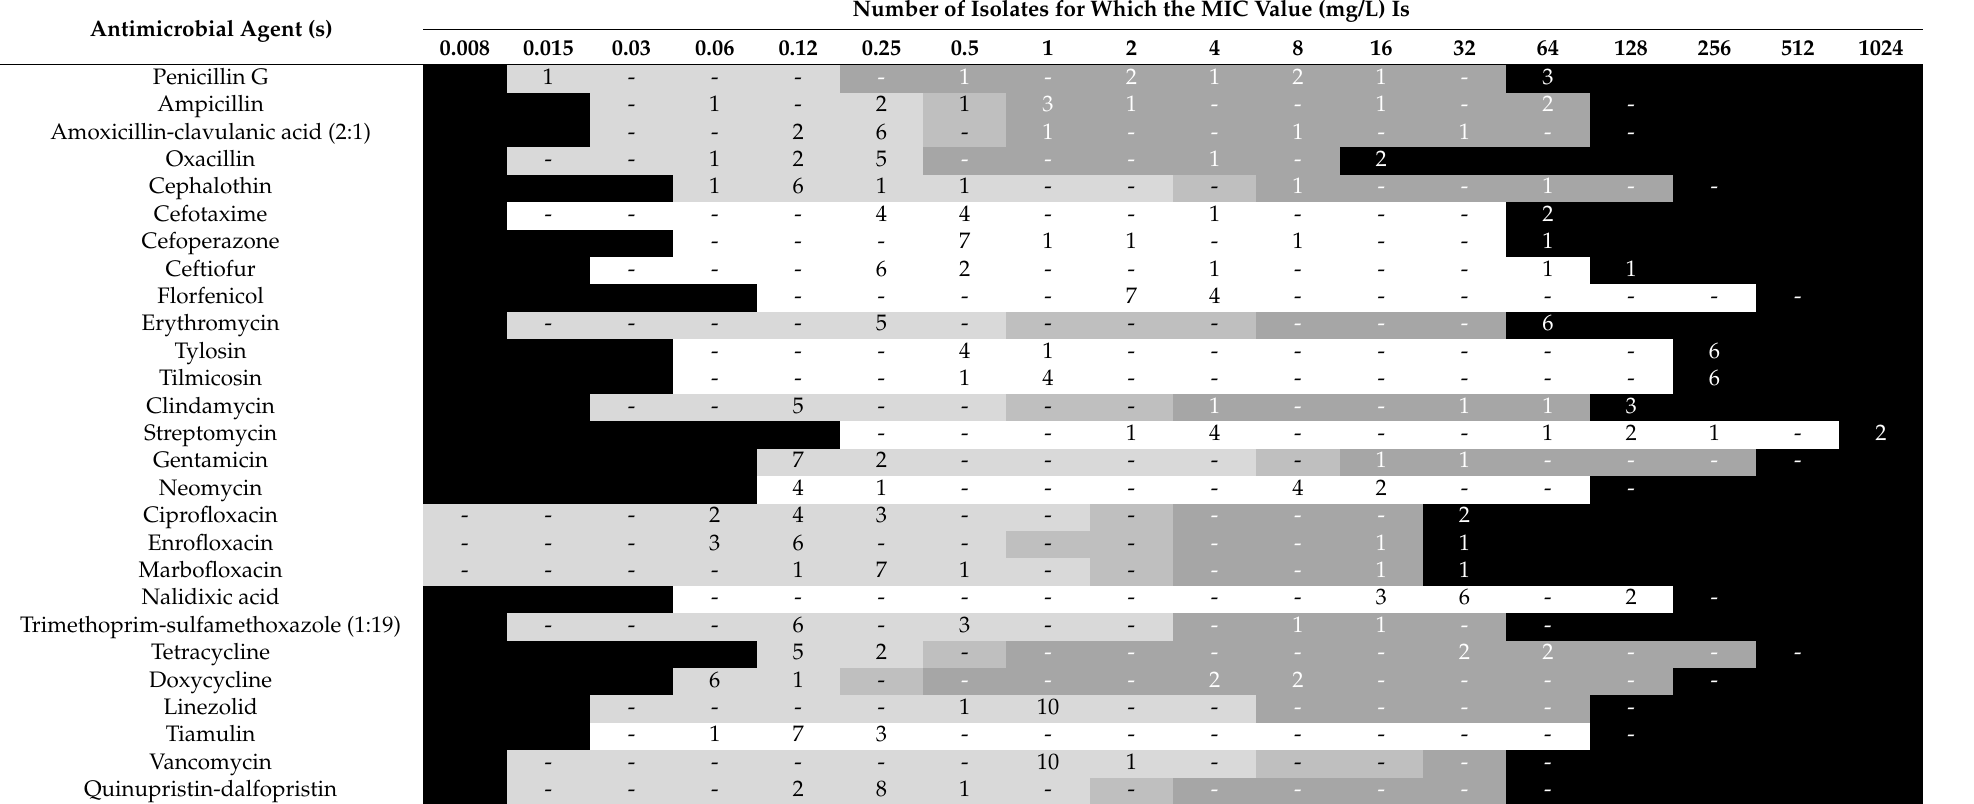
Table 3. Minimal inhibitory concentrations of the 11 feline S. pseudintermedius isolates. Antimicrobial Agent